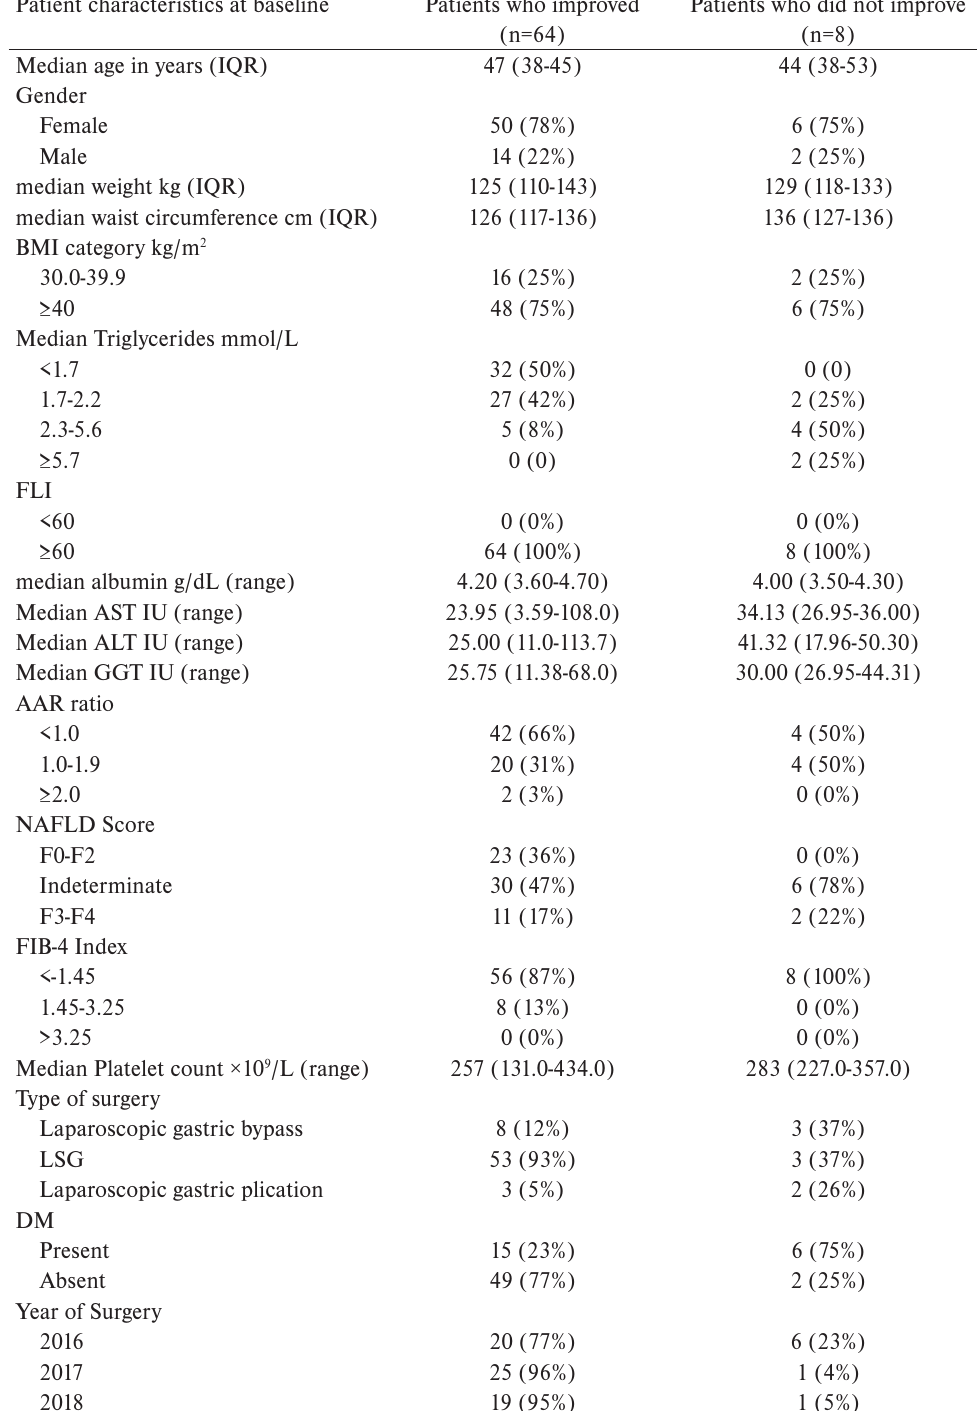
Table 5. Comparison of patients who had improvements in weight and metabolic derangements one year following bariatric surgery at the University Hospital Ostrava, Czech Republic, 2016-2018. Patient characteristics at baseline Patients who improved